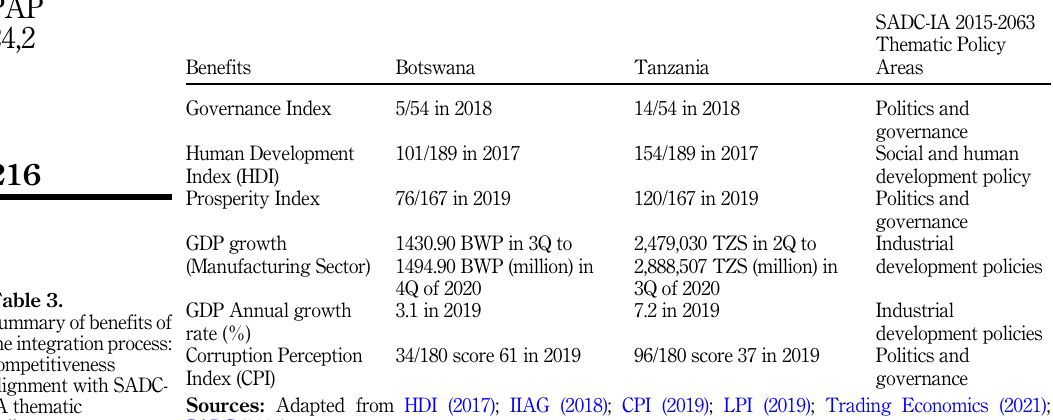
Table 3. Summary of benefits of the integration process: competitiveness alignment with SADC- IA thematic policy areas